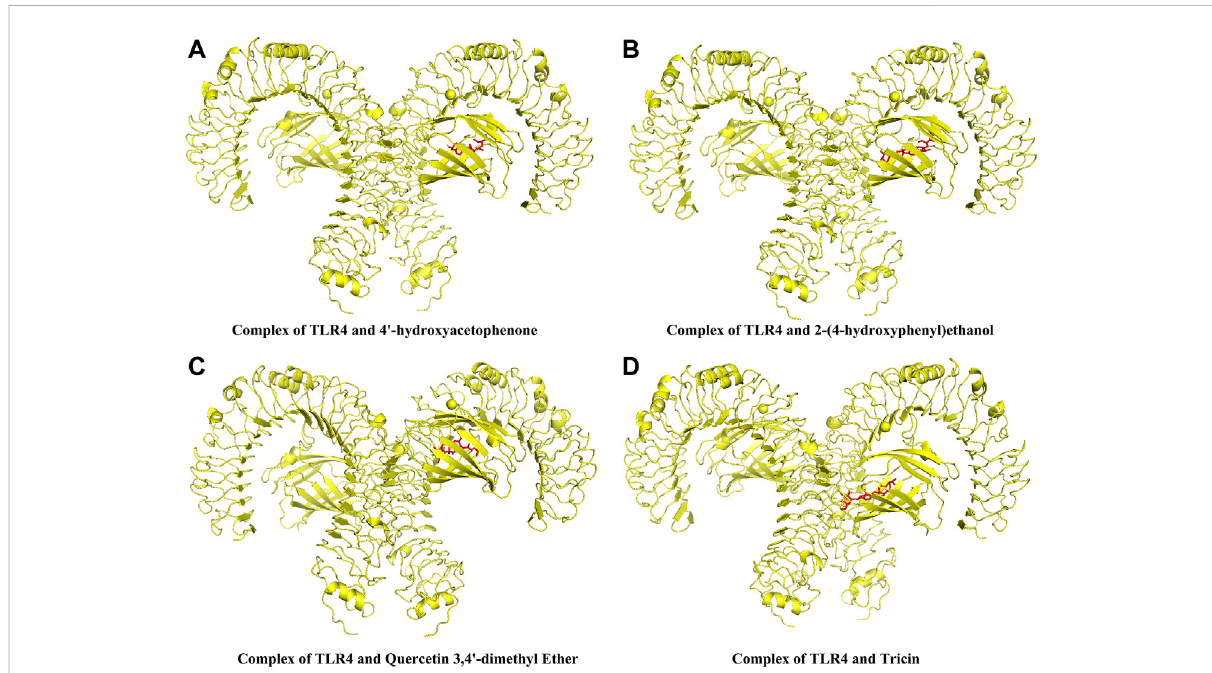
FIGURE 6 ThedockingcomplexbetweenthechemicalcomponentsofELBandTLR4.Thecomplexesofthetop4highestscoringswereshown.Complex of TLR4 and 4 ′ -hydroxyacetophenone (A) . Complex of TLR4 and 2-(4-hydroxyphenyl)ethanol (B) . Complex of TLR4 and Quercetin 3.4 ′ -dimethyl Ether (C) . Complex of TLR4 and Tricin (D)